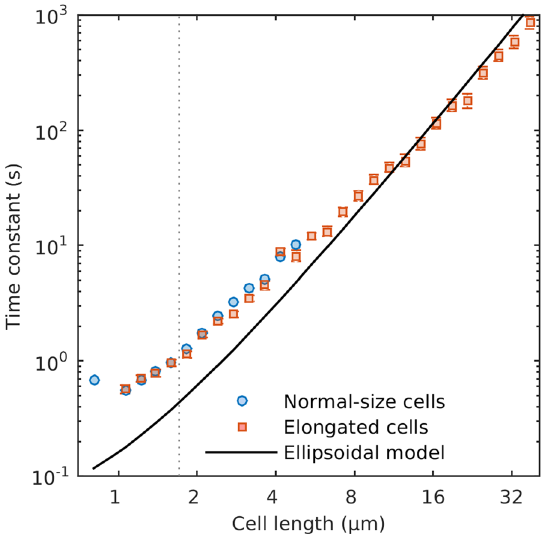
Figure 3. Time constant, i.e. the time it takes for a running cell to lose the original orientation, vs. cell length. Blue circles represent control cells, and red squares represent cephalexin treated cells. Error bars are the 95% confidence intervals of the linear regression least-squares estimate of the time constant (see Methods). Vertical dotted line marks the average length of untreated E. coli . Solid line is the theoretical time constant of an ellipsoid of revolution. Note the base-2 logarithmic axis for cell